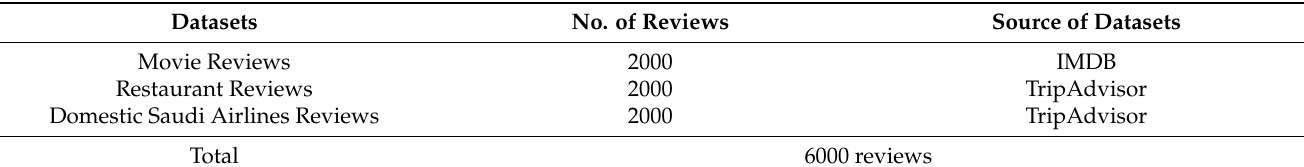
Table 1. Summary of the